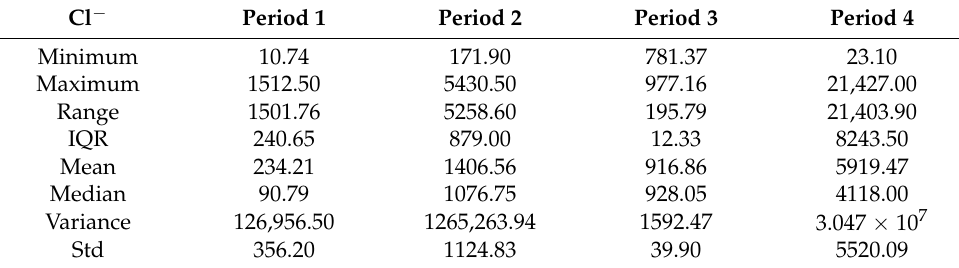
Table 2. Summary statistics for Cl − in different